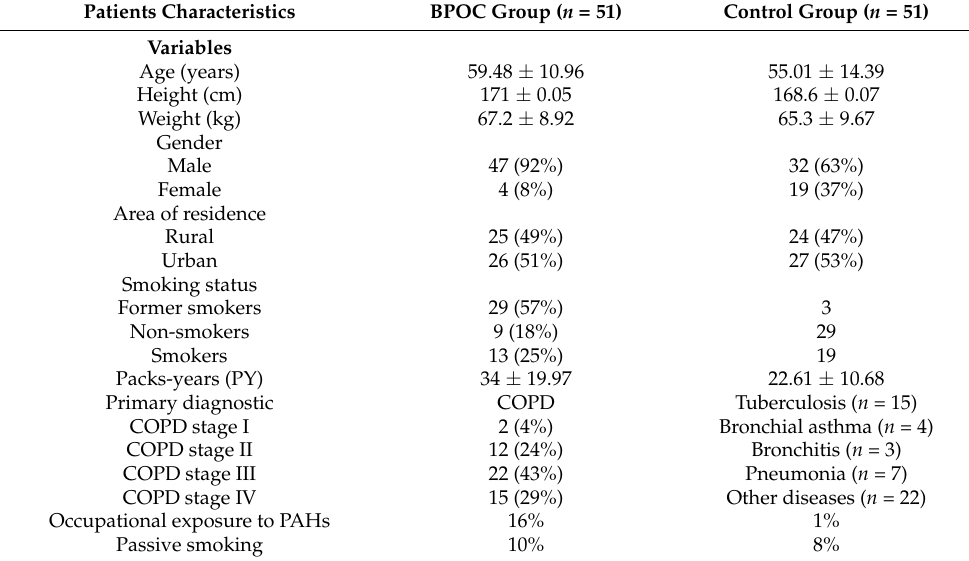
Table 1. Clinical and demographic characteristics of patients diagnosed with